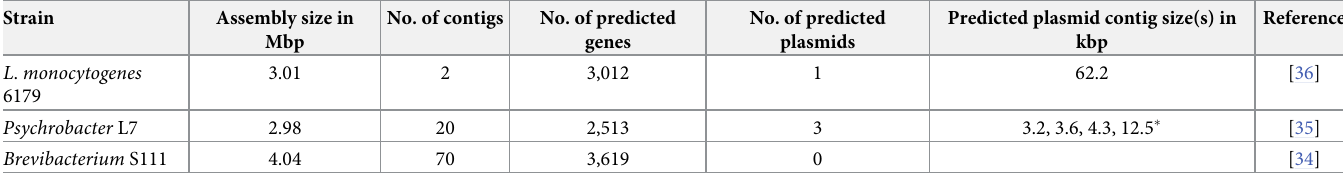
Table 1. General genetic features of the L . monocytogenes 6179, Psychrobacter L7, and Brevibacterium S111 genomes.